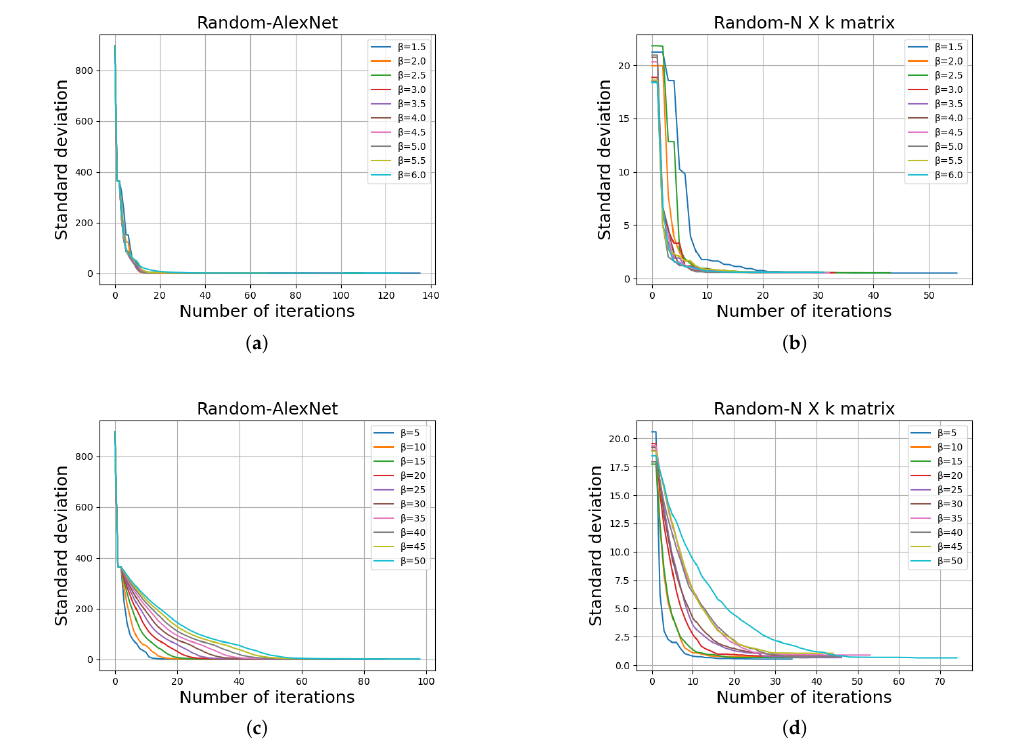
Figure 4. For k = 128, the performance of our method with various decay rate β in the Algorithm 1 is given. The x axis is the number of iterations and y axis is the standard deviations for the distribution of pseudo-labels. In ( a , c ) the method is applied on the outputs of CIFAR-10 from randomly weighted AlexNet; in ( b , d ) the method is applied on N × k matrices randomly